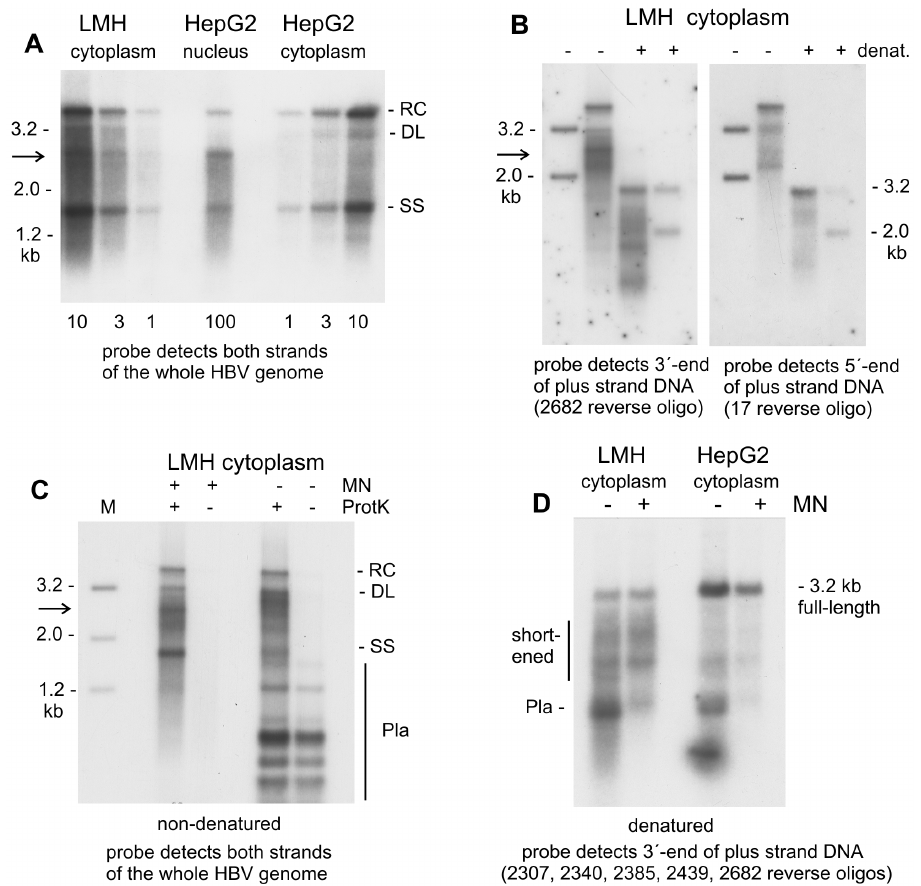
Figure 3. Detection of shortened HBV genomes in the cytoplasm of LMH cells. Transfection was done with a plasmid coding for splice- deficient virus with the natural HBV core promoter driving transcription of pgRNA and the surface protein coding sequence mutated. ( A ) Viral DNA from cytoplasm of LMH cells was compared with viral DNA from HepG2 cell nuclei and HepG2 cytoplasm. Preparation of viral DNA involved nuclease treatment of cytoplasmic lysates and purified cell nuclei. Numbers below indicate relative amounts of DNA loaded in the respective lanes. Hybridisation was done with a probe encompassing both strands of the whole HBV genome. The arrow points to a prominent DNA species obtained both in cytoplasm of LMH cells and nucleus of HepG2 cells. ( B ) Viral DNA from transfected LMH cells was denatured ( + / 2 denat) by heating before gel loading, as indicated. Hybridisation was done with 32 P-labelled oligonucleotides detecting either the 3 9 -end or the 5 9 -end of plus-strand DNA at genome positions 2682 and 17 (see map of the HBV genome in Figure 1D). Positions of the 3.2 kb and 2.0 kb marker fragments are indicated. The arrow points to viral genomes migrating between these marker fragments. ( C ) Viral DNA was prepared from cytoplasm of transfected LMH cells with or without micrococcal nuclease ( + / 2 MN) treatment and with or without protease ( + / 2 ProtK) digestion done before phenol extraction. The purified DNA was digested with restriction enzyme Dpn I, which selectively cuts transfected plasmid (Pla) into multiple short fragments. Southern blot hybridisation was done with a probe covering both strands of the whole HBV genome. This probe also detects several Dpn I fragments of transfected plasmid DNA. ( D ) Viral DNA was prepared from cytoplasm of HepG2 and LMH cells with or without micrococcal nuclease ( + / 2 MN) treatment. Purified DNA was subsequently digested with restriction enzyme Dpn I and denatured by heating before gel electrophoresis. Southern blot hybridisation was done with a mixture of 32 P-labeled oligonucleotide complementary to the 3 9 -end of plus-strand DNA at genome position 2307, 2340, 2385, 2439 and 2682. These five oligonucleotides were combined to enhance sensitivity. The vertical lane on the right side indicates shortened plus-strand molecules. The probe detects a 0.8 kb Dpn I fragment of the transfected plasmid (Pla) if micrococcal nuclease treatment is not done.